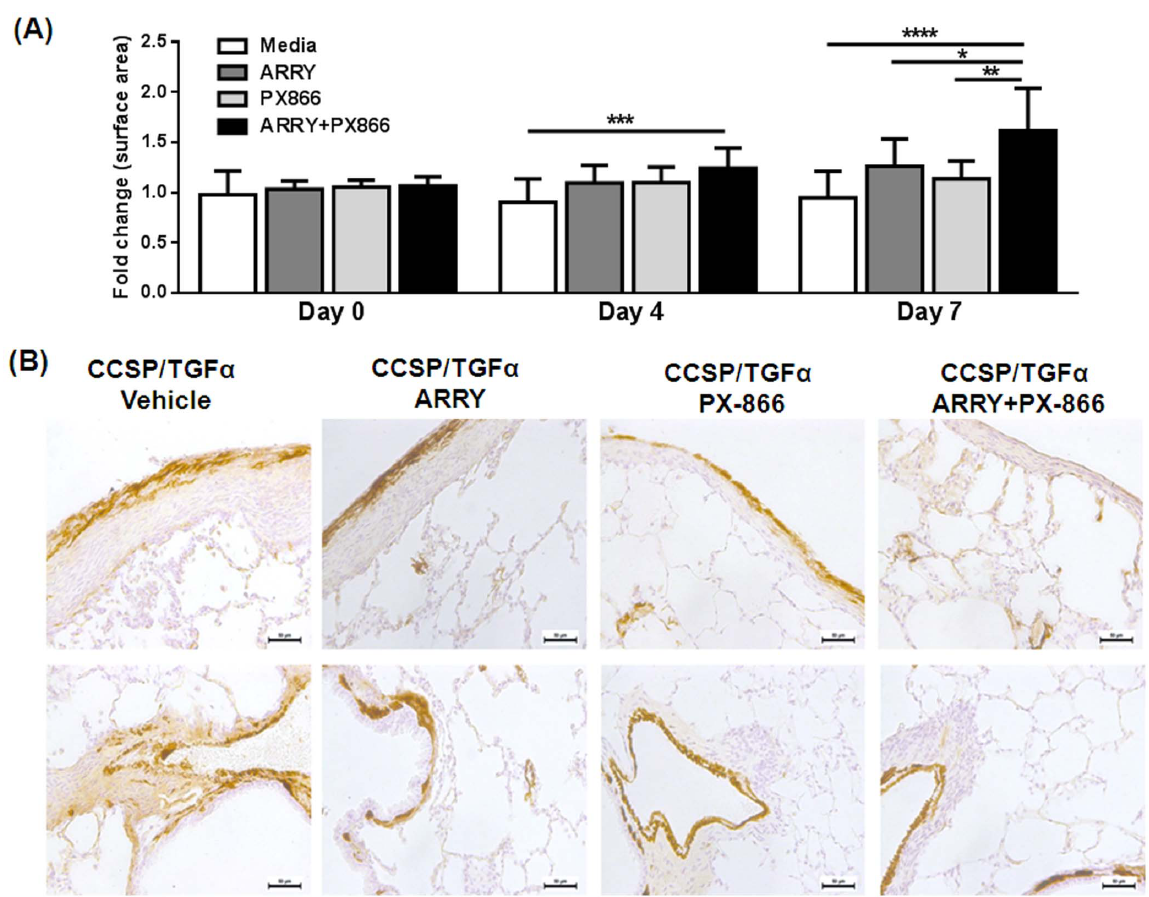
Figure 4. Inhibition of MEK and PI3K in combination alters contraction of collagen gels and SMA deposition in the lungs. (A) Primary fibroblasts from the lung cultures of CCSP/TGF a transgenic mice on Dox for 4 wks were platted in 3D collagen gels for 4 or 7 days with media, ARRY, PX866 or inhibitors combined. Images were taken to quantify the changes in the surface of 3D collagen gels (B) Representative photomicrographs of lung tissues for each treatment group (n=4/group) demonstrate changes in SMA staining in the fibrotic lesions of the pleura (upper panel) and adventitia (lower panel).